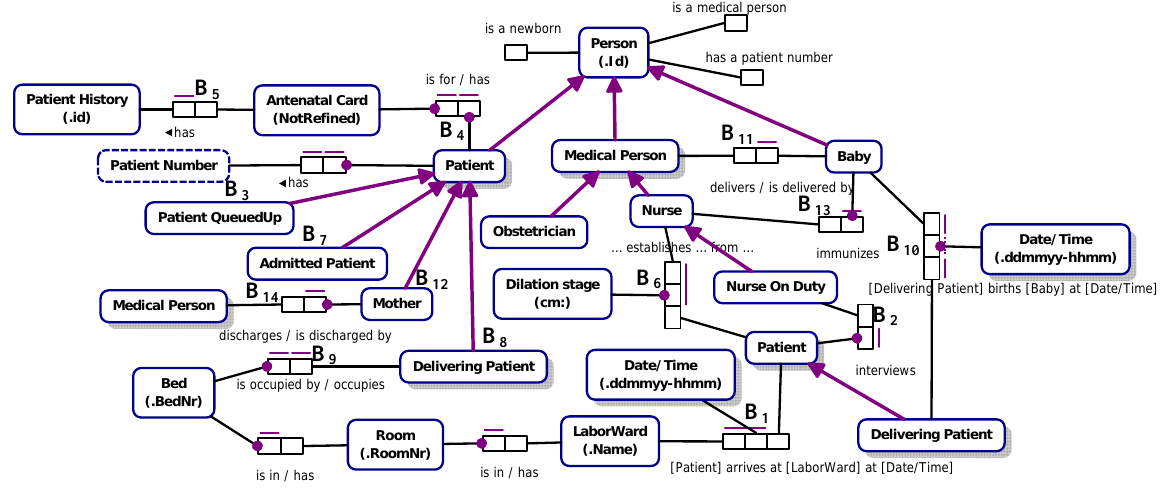
Figure 6. ORM Scheme for the intrapartum process in Ugandan